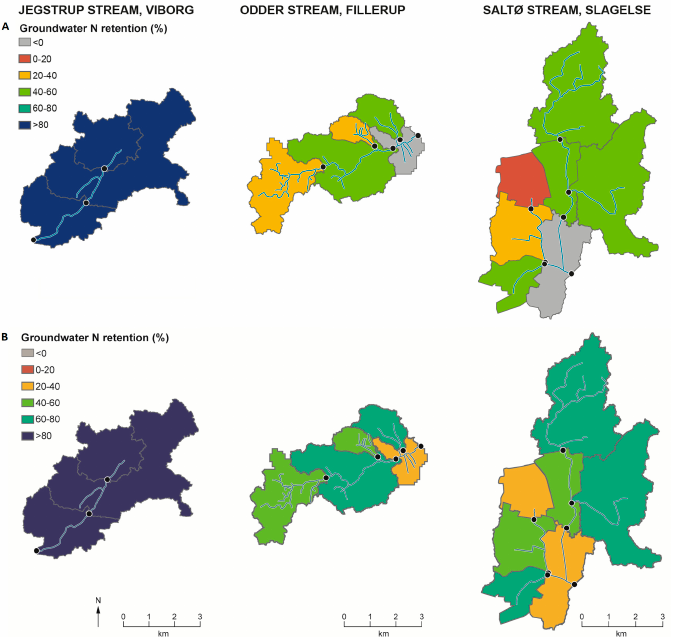
Figure 5. N retention in groundwater in the three catchments of Jegstrup, Odder, and Saltø. ( A ) Average TN retention in groundwater from 2015 to 2016 in the sub-catchments. The retention was calculated based on bias-corrected TN emissions from agricultural areas. ( B ) Average nitrate-N (NO 3 -N) retention in groundwater from 2015 to 2016 in the sub-catchments. The retention was calculated based on bias-corrected NO 3 -N emissions from agricultural